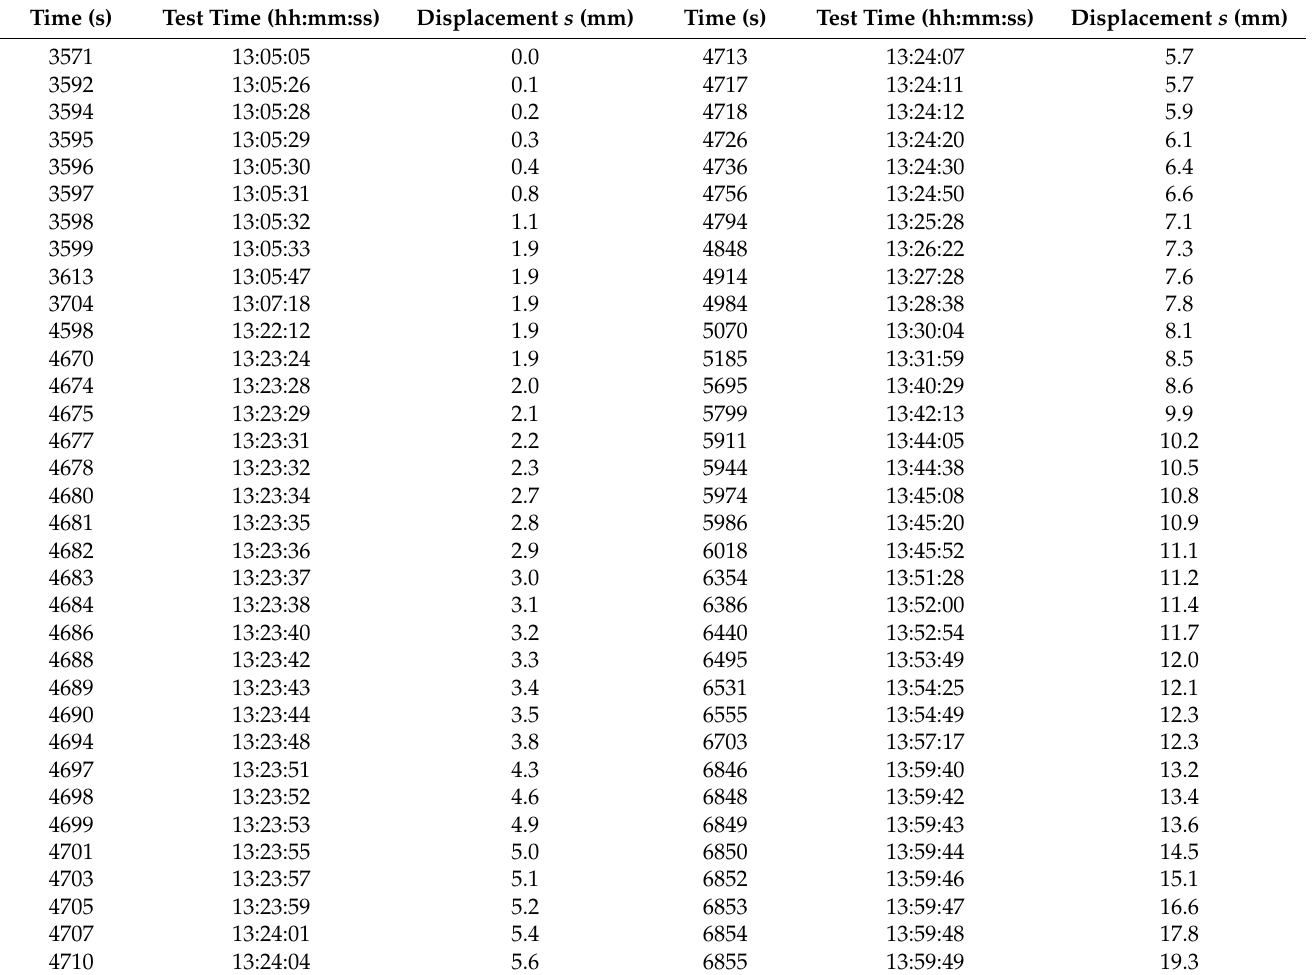
Table A1. Displacements of the cohesive central core tested in MAIN1.